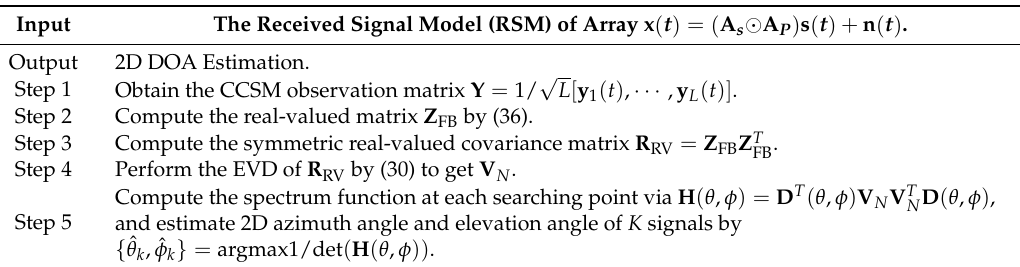
Table 1. Implementation steps of the entire